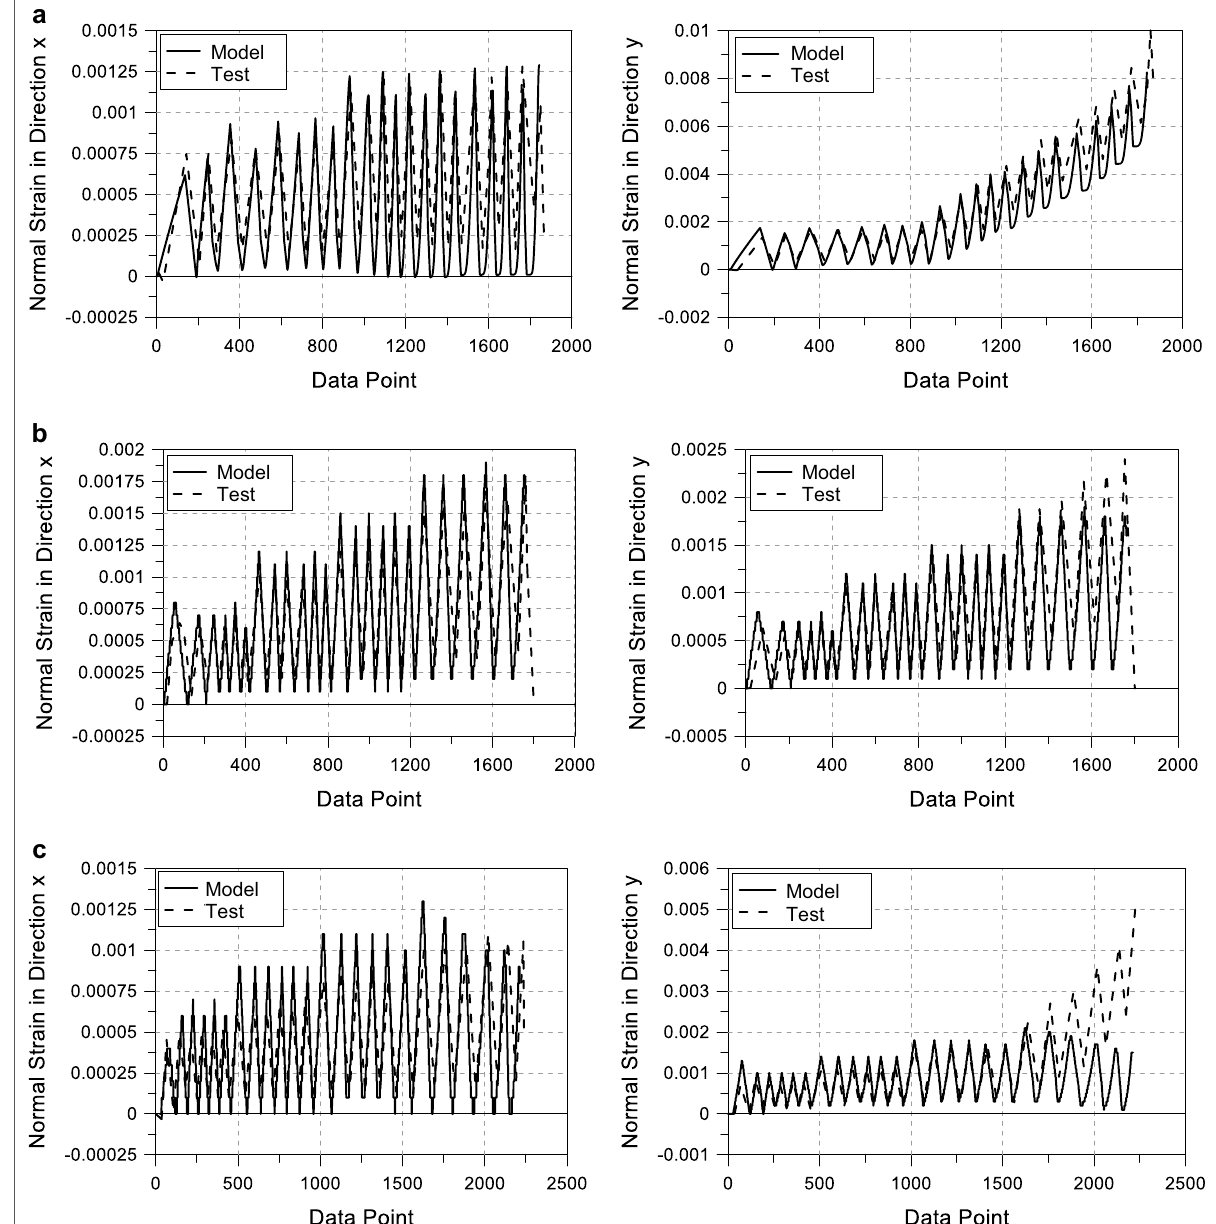
Fig. 5 Measured vs. predicted normal strains in x and y directions: a Specimen SE8, b Specimen SE9, c Specimen